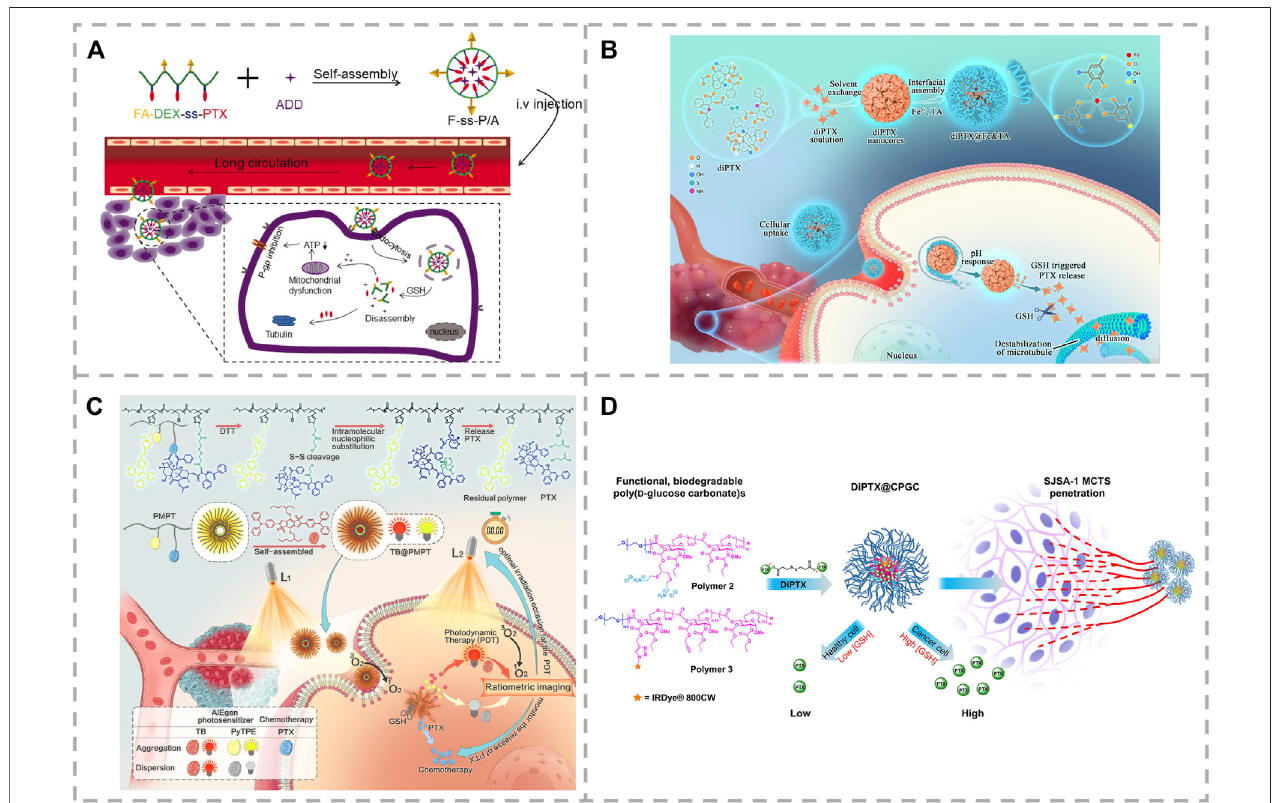
FIGURE2|(A) Releaseand mechanismoftheself-assemblyofF-ss-P/Amicelles(Chenetal.,2020). (B) Synthesis andmechanismofPTXreleasefrompolymeric prodrugofTB@PMPT (Yietal.,2021). (C) Procedure,intracellular pH,andreduction-sensitiveofprogrammed drugreleasefromdimericprodrugnanoparticles(Yietal., 2022). (D) Release of PTX from the poly (ethylene glycol) (PEG)-protected reduction-sensitive dimeric PTX (diPTX)-loaded cationic poly (D-glucose carbonate) micelle (diPTX@CPGC) (Su et al.,